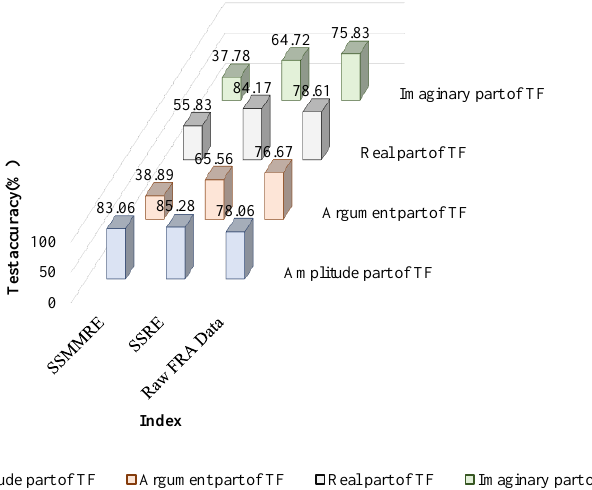
Figure 9. Evaluating the performance of the MLP model in the determination of the DSV fault severity using direct data of FRA and the extracted features by statistical indices.